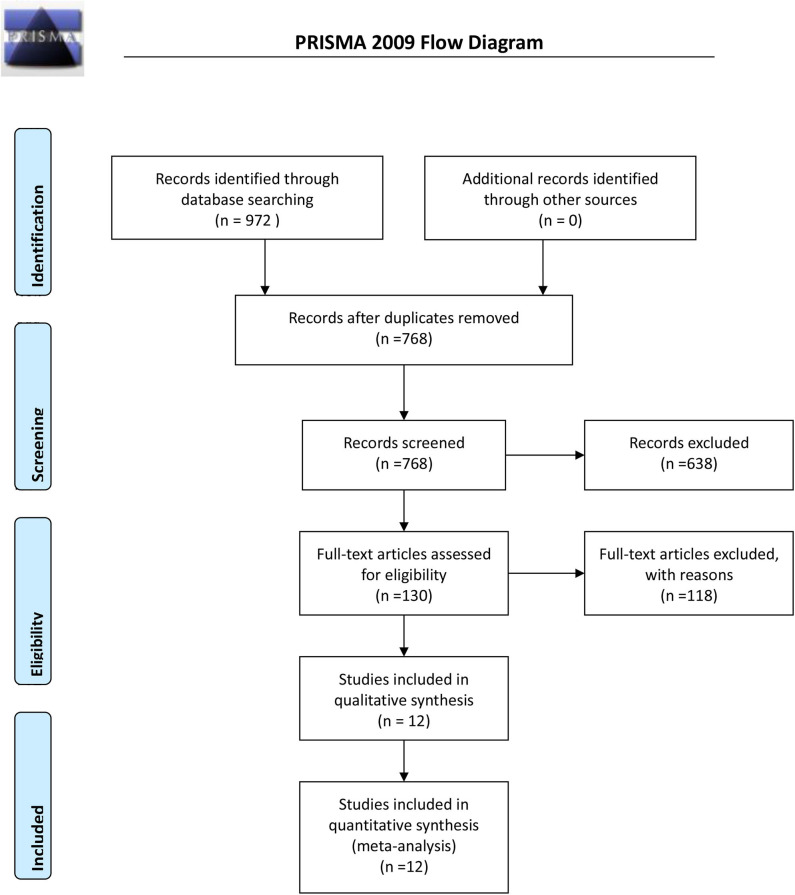
Flow diagram of the search procedure.